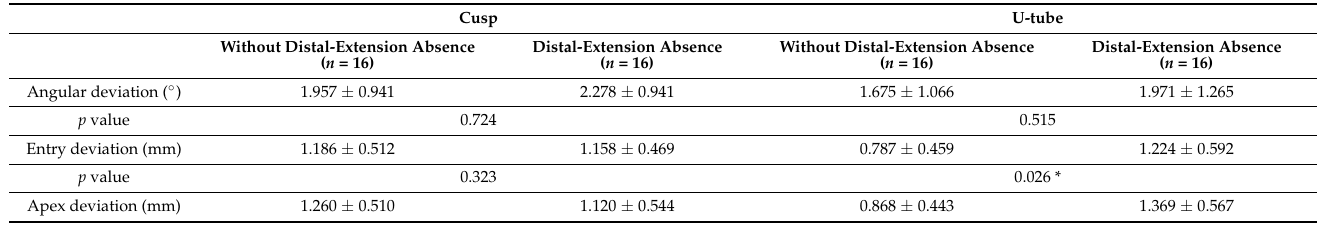
Table 2. Directions of horizontal deviation of the implant position obtained by the DNS-based